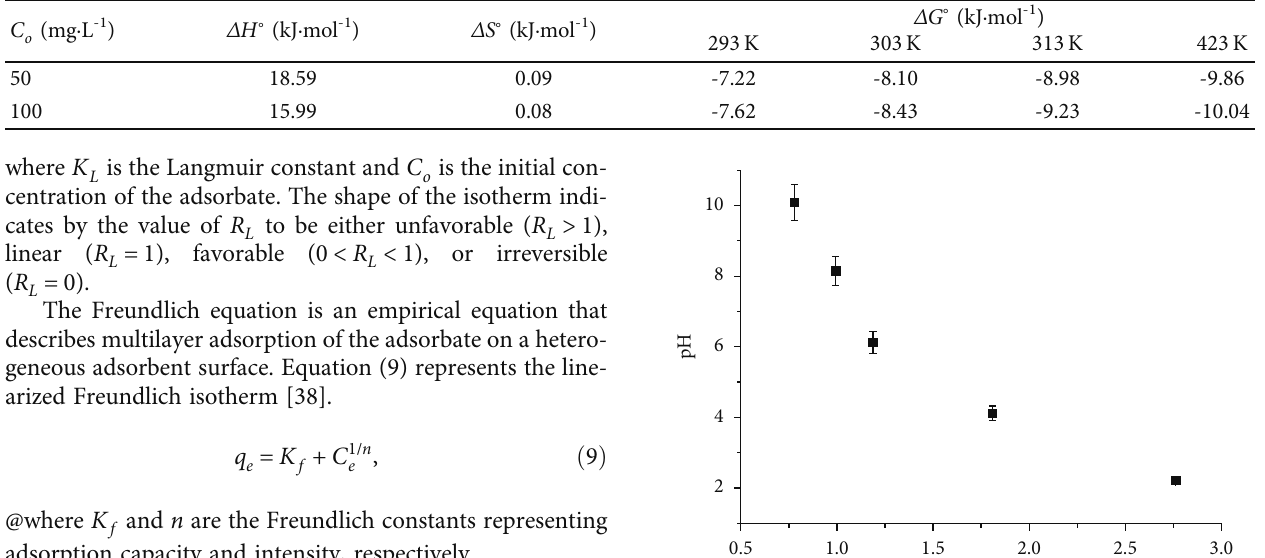
Table 3: Thermodynamic parameters for the adsorption of BF dye onto TKC.